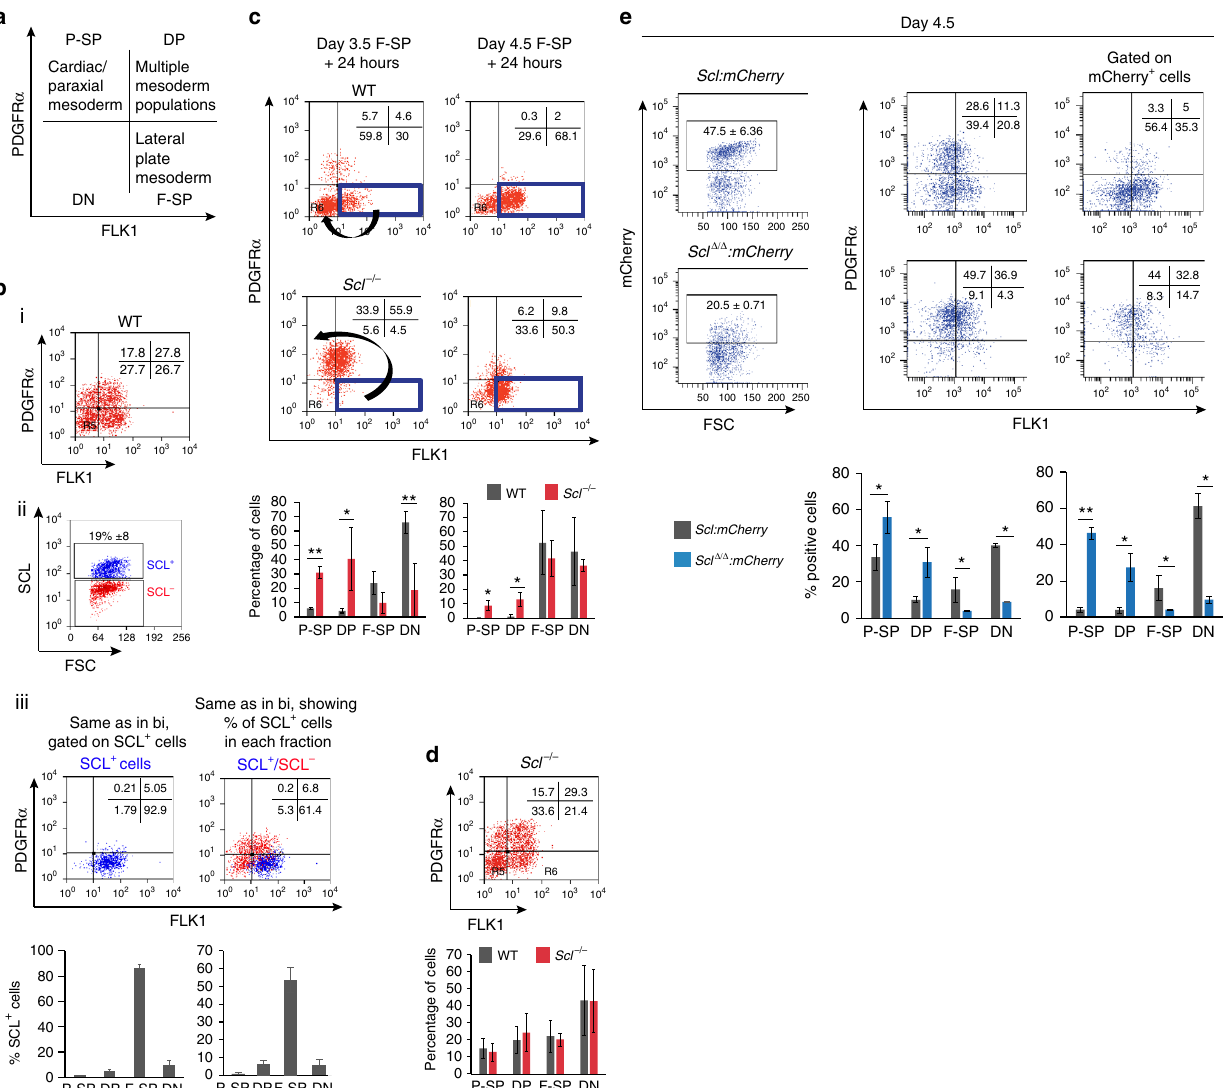
Fig. 2 Immunophenotypic conversion of Scl -null FLK1-single positive cells. a Days 3.5/4 ES cell-derived mesodermal populations are functionally de fi ned by expression of cell surface markers FLK1 and PDGFR α . P-SP, PDGFR α single positive; DP, double positive; F-SP, FLK1 single positive; DN, double negative. b (i) Distribution of FLK1- and PDGFR α − positive populations in WT day 3.5 EBs. (ii) SCL protein expression in day 3.5 WT EBs (intra-cellular FACS). (iii) Left, top, distribution of FLK1/PDGFR α -positive cells shown in bi and gated on SCL-positive cells; bottom, mean of 9 independent experiments; Right, top, distribution of SCL + cells in each FLK1/PDGFR α compartment. Blue events: SCL + cells, red events: SCL - cells; bottom, mean of 9 independent experiments. c Re-aggregation assays. F-SP populations were FACS-sorted from WT and Scl -/- EBs (left panels, day 3.5; right panels, day 4.5), allowed to re-aggregate for 24 h and analysed for FLK1/PDGFR α expression. The arrows show the different immunophenotypic conversions of WT and Scl -/- cells at day 3.5 + 24 h. Bottom, mean of two independent experiments. d Top, distribution of FLK1-positive and PDGFR α -positive populations in Scl -/- day 3.5 EBs; bottom, comparison with WT cells (shown in bi), mean of 4 independent experiments. e Scl:mCherry and Scl Δ / Δ :mCherry reporter lines analysed in day 4.5 EBs. Representative FACS plots of mCherry expression (left), FLK1/PDGFR α expression (middle) and FLK1/PDGFR α plots gated on mCherry-positive cells (right) are shown. Below, mean of 2 independent experiments. Mean± SD is shown in b – e ; student ’ s t -test, * p < 0.05, ** p < 0.01. Scale bars, 100 μ m. See also Supplementary Fig.